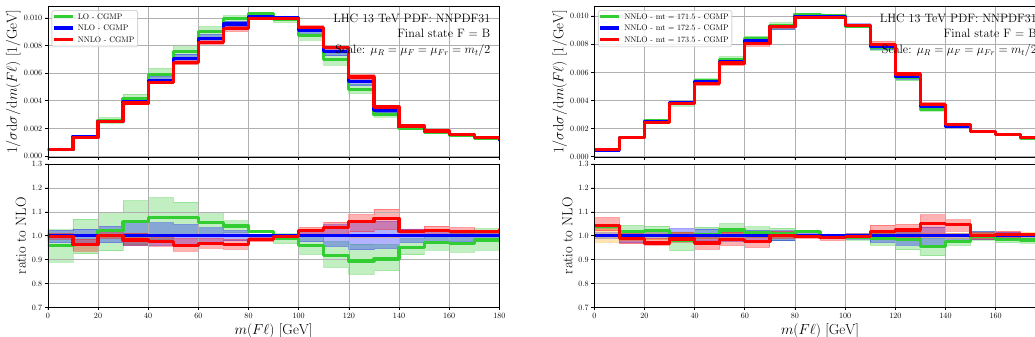
Figure 13 . (Left): the normalized m ( B‘ − ) distribution for fixed scale (3.2). Shown are the 15 point scale variation bands for LO, NLO and NNLO as well as the NPFF r.m.s. uncertainty band. (Right): the NNLO prediction for 3 different values of m t